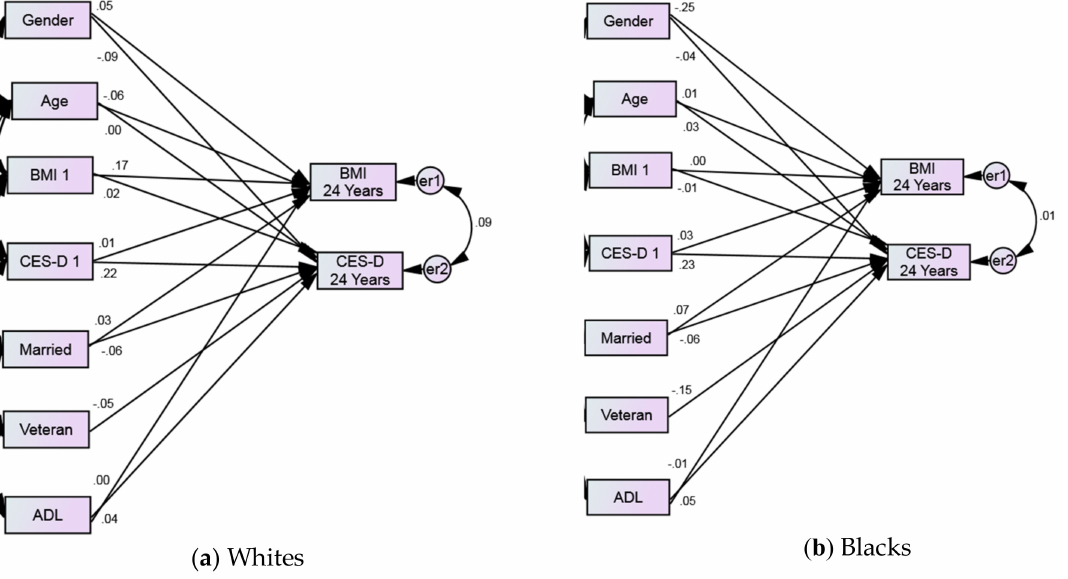
Figure 3. Structural equation model (SEM) based on race. Dependent variables: Average depressive symptoms and BMI over 24 years. Independent variables: baseline depressive symptoms and BMI. Covariates: age, gender, marital status, veteran status, and ADL. Numbers reflect standardized adjusted path coefficients. Probability level = 0.285, chi-square (CMIN) = 2.507, DF = 2, CMIN/DF = 1.254,